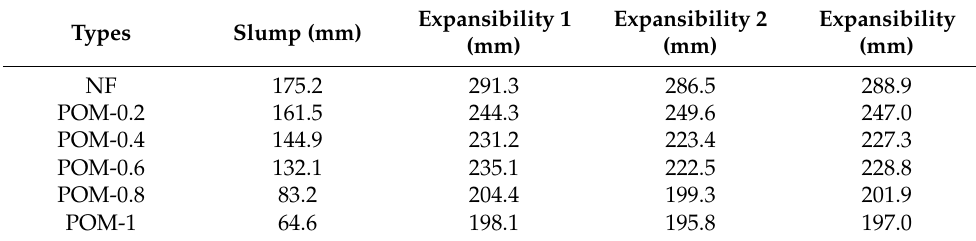
Figure 5. Test results of workability. Table 6. Test results of the workability of